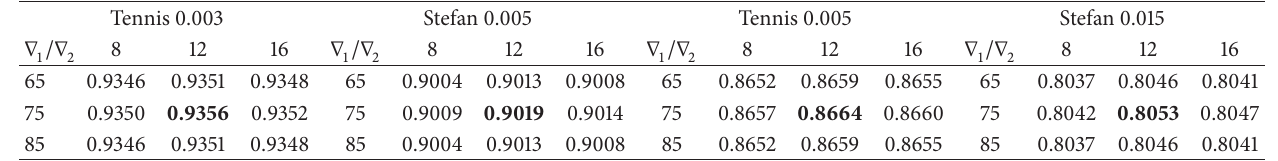
Table 4: SSIM values (dB) for ∇ 1 and ∇ 2 parameters in membership